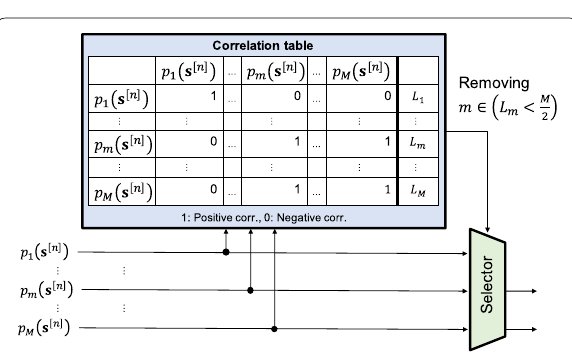
Fig. 4 Relative checking